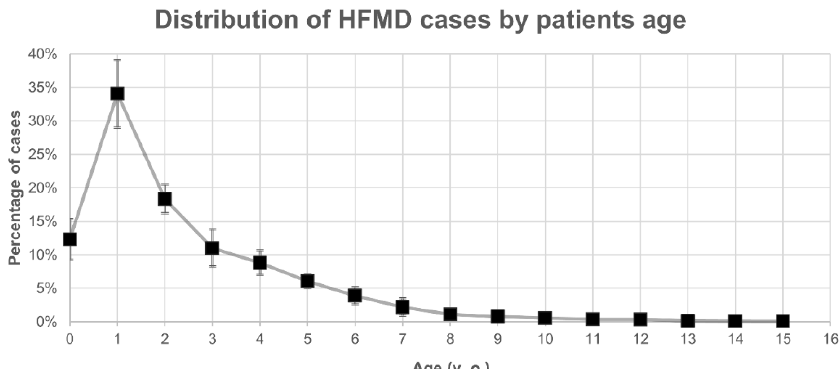
Figure 2. Distribution of HFMD cases by age between 2009 and 2018. The counts of patients were normalized as the percentages of the yearly total number of cases (vertical axis) and then stratified by age (horizontal